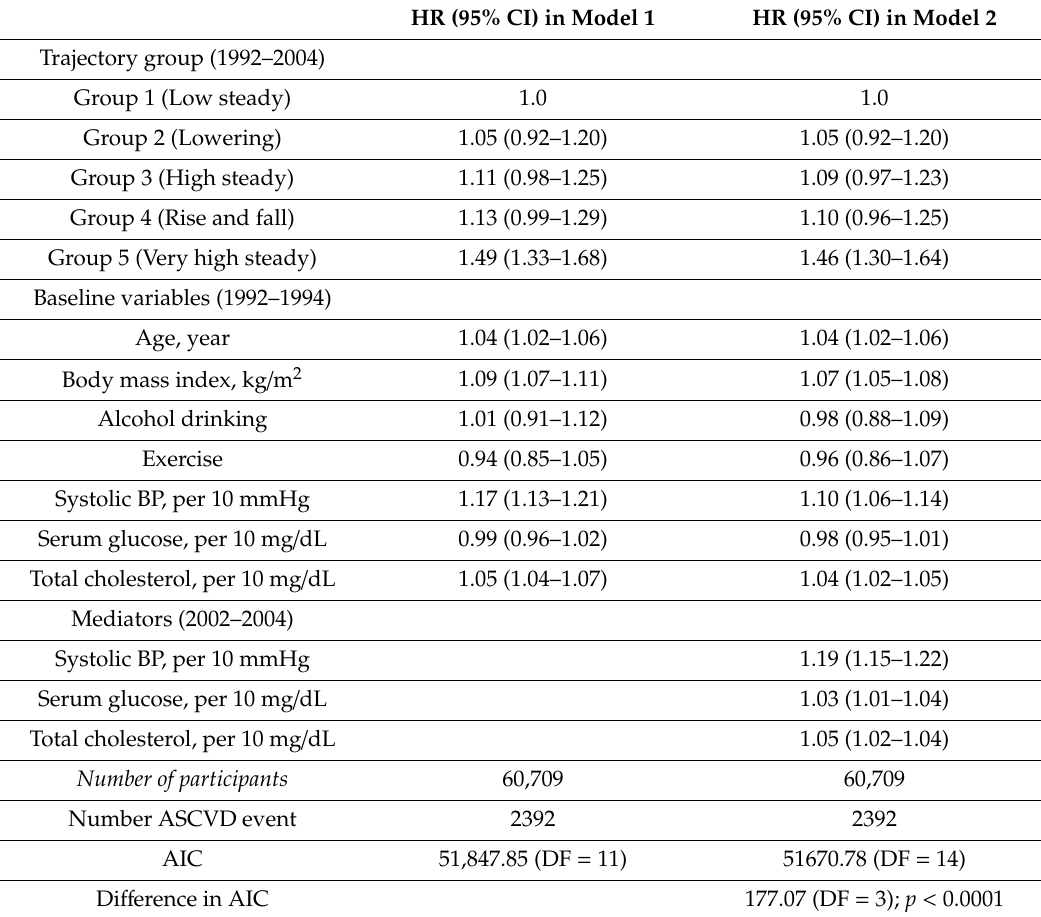
Table 3. Basic model with e ff ect of trajectory groups and mediators on ASCVD events using Cox proportional hazard